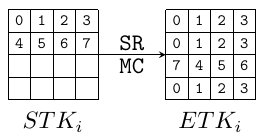
Figure 4: The relations between the cells of STK i and ETK i